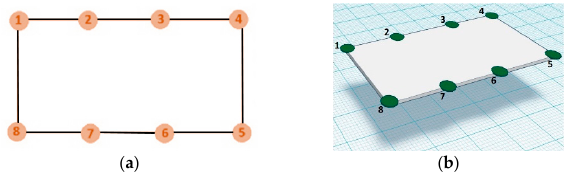
Figure 2. Registration point sets. ( a ) In orange the feature points extracted from the image; ( b ) In green the corresponding workspace coordinate frame points.